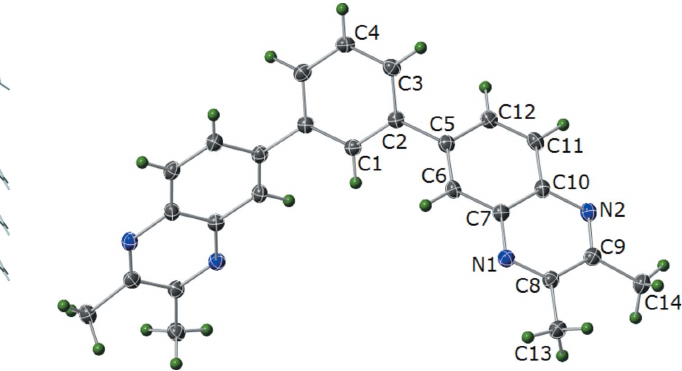
Figure 1 Plot showing 35% probability displacement ellipsoids for non-H atoms and circles of arbitrary size for H atoms for (I). The unlabeled atoms are related by the symmetry operator ( (cid:2) x + 1, y , (cid:2) z + 1